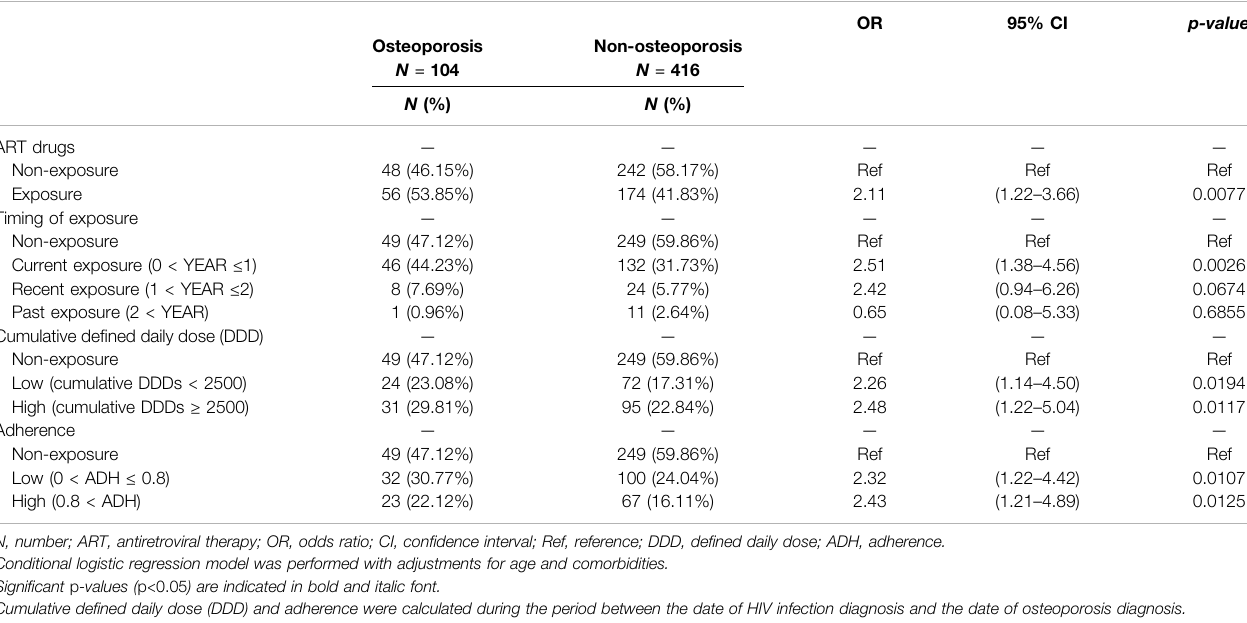
ART use and osteoporosis risk during the study period ( Figure 2 ). Subgroup analyses for speci fi c NRTI- and PI- containing regimens with dose-response relationships were performed to explore the association between the dose effect of